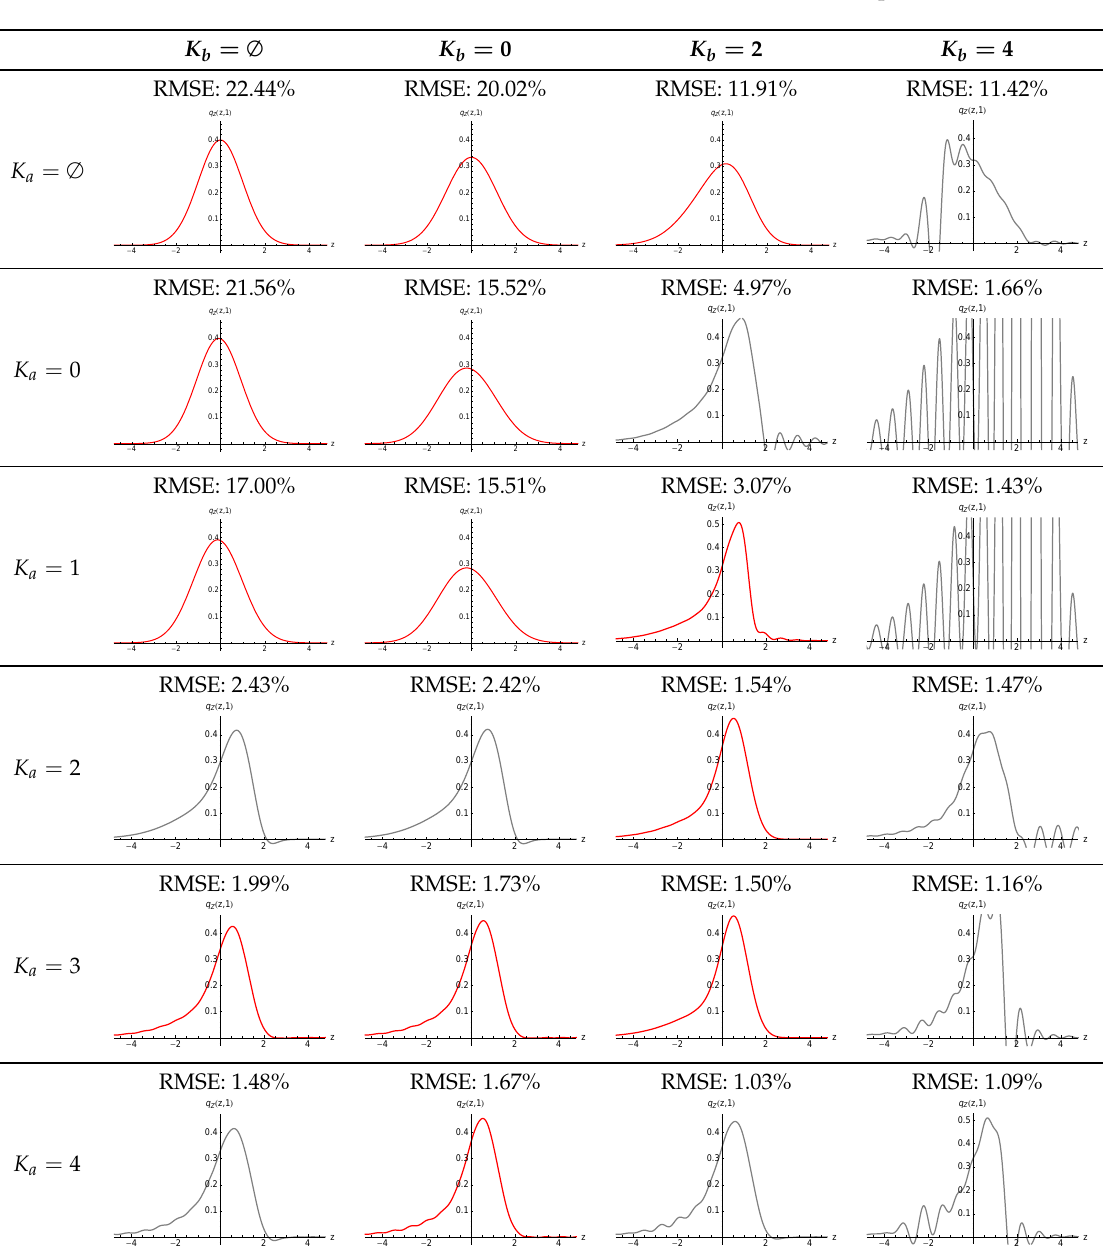
Table 1. Model calibration for n = 45 Fourier -coefficients. RMSE: root-mean-square error. K b = ∅ K b = 0 K b = 2 K b = 4